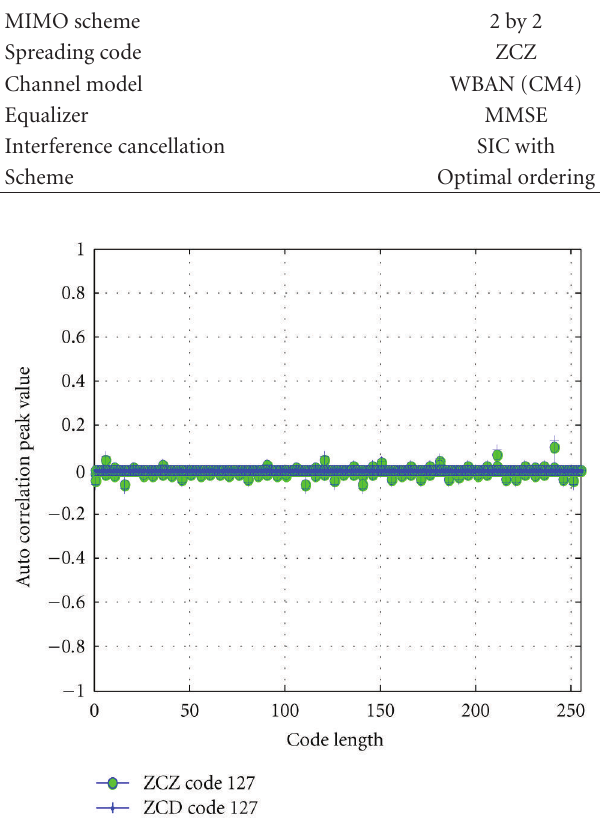
Figure 3: Performance of autocorrelation